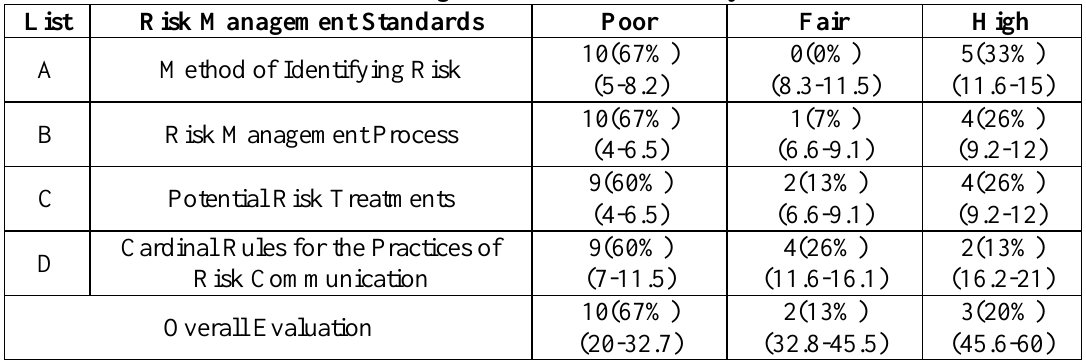
Table (1): Evaluation of Risk Management at Model Primary Health Care Centers List